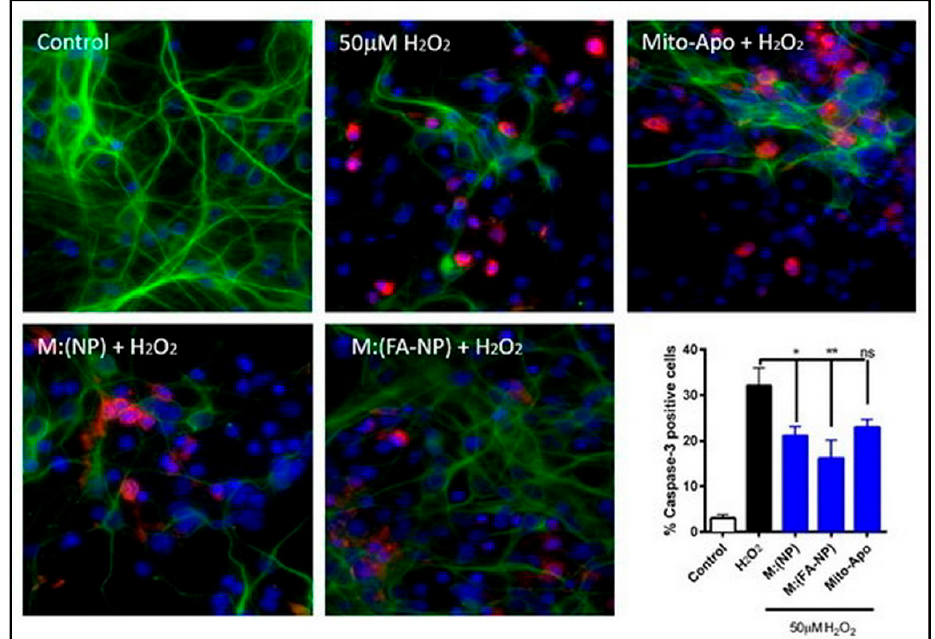
Figure 8. E ffi cacy of Mito-Apo-encapsulated nano-formulations on primary cortical neurons. Neurons were pre-treated with the various nano-formulations for 24 h and challenged with H 2 O 2 for 1.5 h. Neurons were stained for β -III tubulin (green) and cleaved caspase-3 (red). Cell death was quantified by the presence of cleaved caspase-3 and by the reduction in neurite length. Caspase-3-positive cells were quantified as shown in the graph. * = p < 0.05; ** = p < 0.01. Adapted with permission from Ref. [88]. Copyright Elsevier,